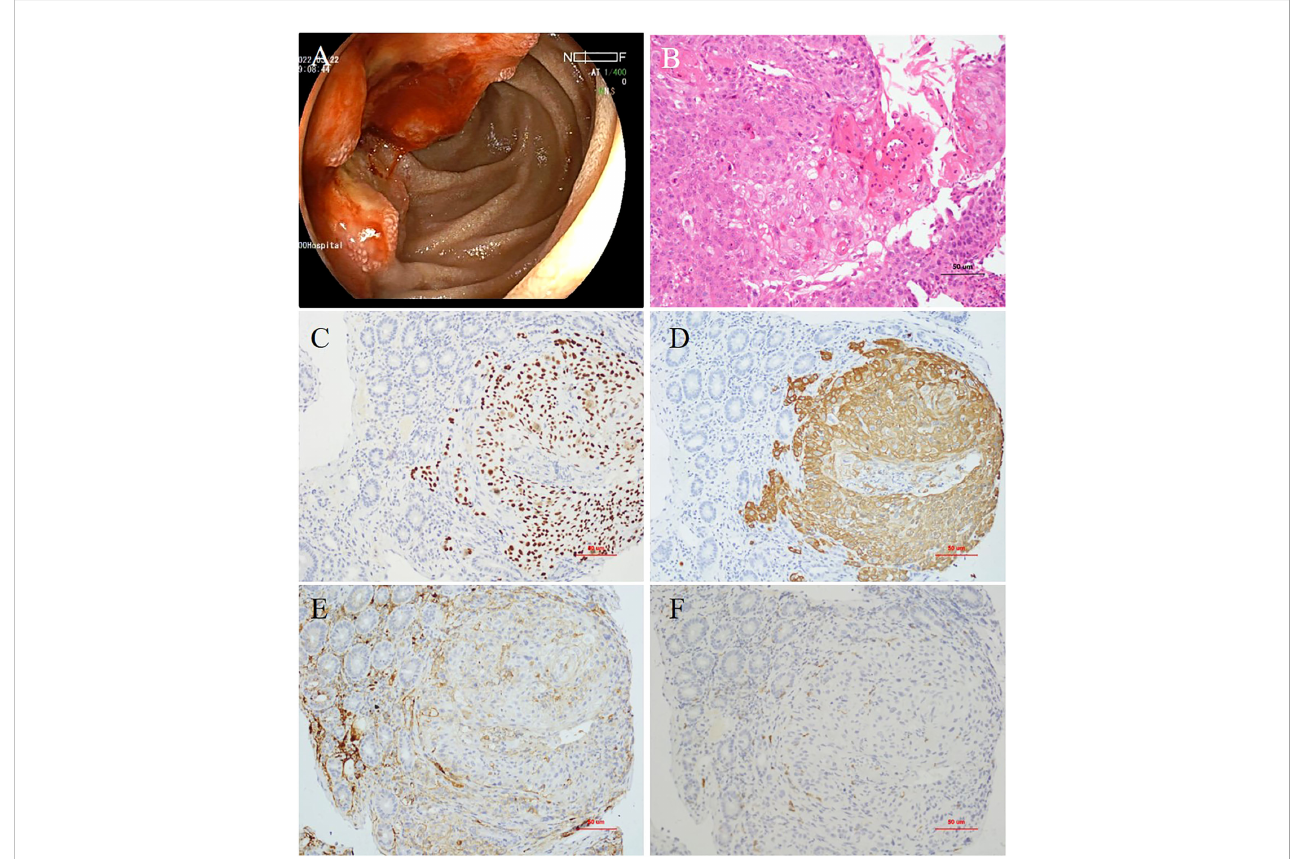
FIGURE 1 (A) Esophagogastroduodenoscopy showing a very large irregular ulcerated tumor in the periampullary area. (B) Histopathology showing invasive moderately differentiated squamous cell carcinoma (hematoxylin and eosin staining, ×200 magni fi cation). (C) Expression of P40 (×200 magni fi cation) and (D) cytokeratin (CK)5/6 detected by immunohistochemistry (×200 magni fi cation). (E) Expression of programmed cell death-ligand 1 (PD-L1; ×200 magni fi cation) and (F) programmed cell death protein-1 (PD-1) detected by immunohistochemistry (×200 magni fi